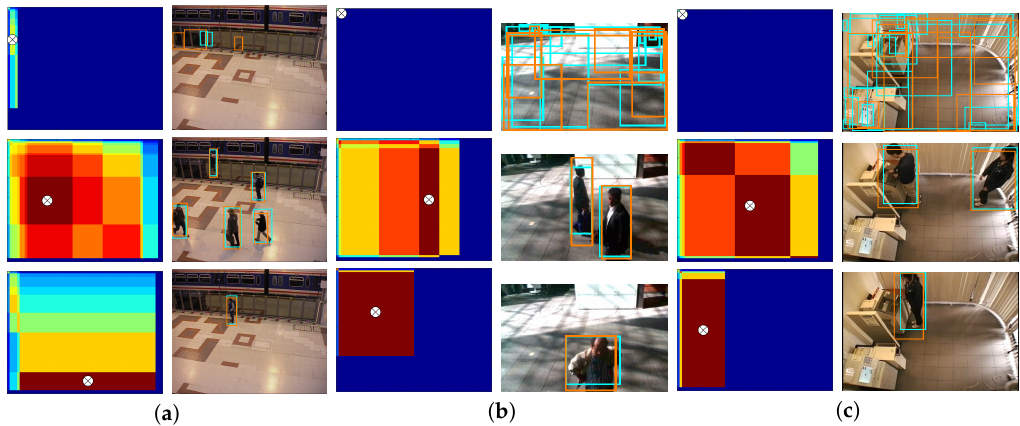
Figure 10. Correlation and threshold selection results between pairs of detectors. Each column pair shows an example of the selected thresholds (cross-marked) in the correlation map (left column) and the corresponding obtained bounding boxes (right column). Column pairs correspond to: ( a ) Faster R-CNN [1] using VGG (cyan) and ZF (orange) models; ( b ) DPM[32] using Inria (cyan) and Pascal (orange) models; and ( c ) ACF [41] using Inria (cyan) and Caltech (orange) models.